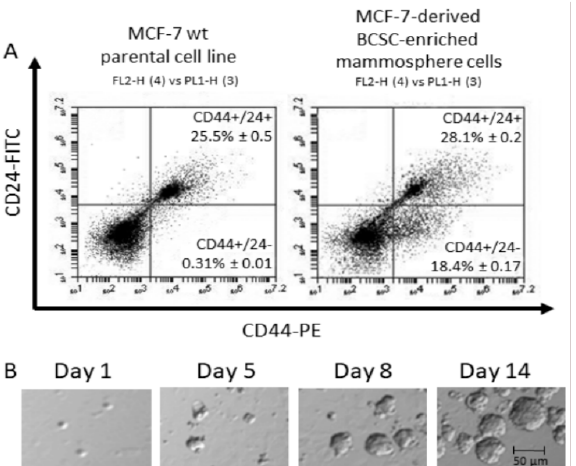
Figure 1. Phenotypic characterization of MCF-7-cell-derived mammospheres. ( A ) Flow cytometry was used to estimate the percentage of CD44+/CD24– cells (mean ± SD from three independent experiments) in parental MCF-7 cultures (monolayer) and MCF-7-derived mammosphere cultures. ( B ) Phase-contrast microscopy was used to monitor mammosphere growth over 14 days. Images are representative of at least 3 independent